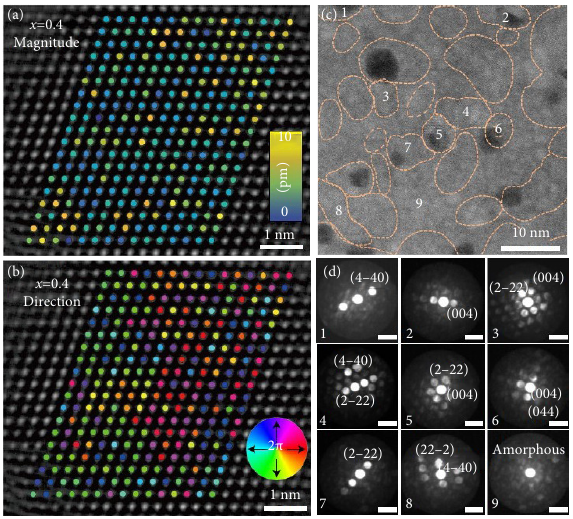
Fig. 1 Lattice distortion, nano-crystalline grains and amorphous-like phase in the high-entropy films. Lattice distortion illustrated by the mappings of magnitude (a) and direction (b) of cation displacements in the x = 0.4 film. (c) Low-magnification HAADF image of the x = 0.4 film, showing the coexistence of nano-crystalline grains (numbered 1–8) and an amorphous-like phase (no. 9). (d) NBD patterns of the nano-crystalline grains and amorphous-like phase labeled by 1–9 in (c). The scale bars are 5 nm −1 , and the diameter of the NBD probe is ~2 nm. Reprinted with permission from ref. [1], © The Author(s), under exclusive licence to Springer Nature Limited